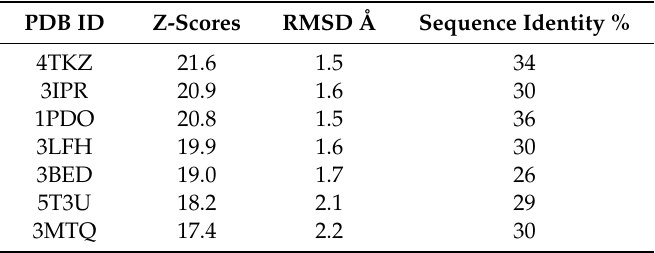
Figure 5. Overlay of reported X-ray structures of EIIA subunits from mannose transporters; for sake of clarity only 4 highest scoring hits out of 8 structures are displayed: 6FMG— S. pneumoniae (this study, orange), 4TKZ— S. agalactiae (purple), 3IPR— E. faecalis (yellow) and 1PDO— E. coli (green). The conserved residues are shown in the stick model (based on structure of SpEIIA-Man determined in this study). Table 2. Results from DALI search with 6FMG structure.